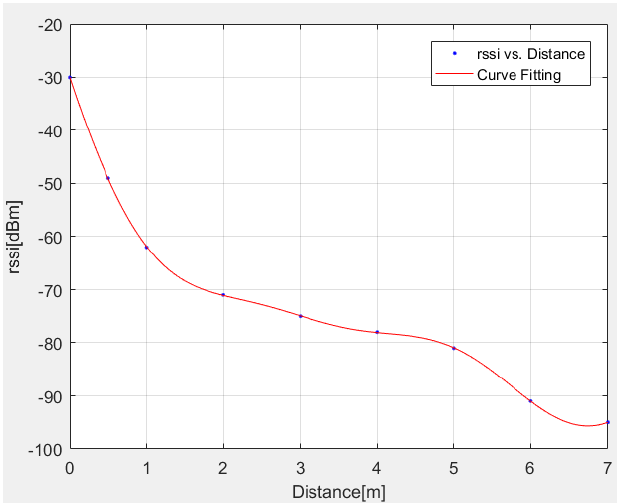
Figure 3. Comparison between exact and interpolated (Equation (14)) RSSI data.